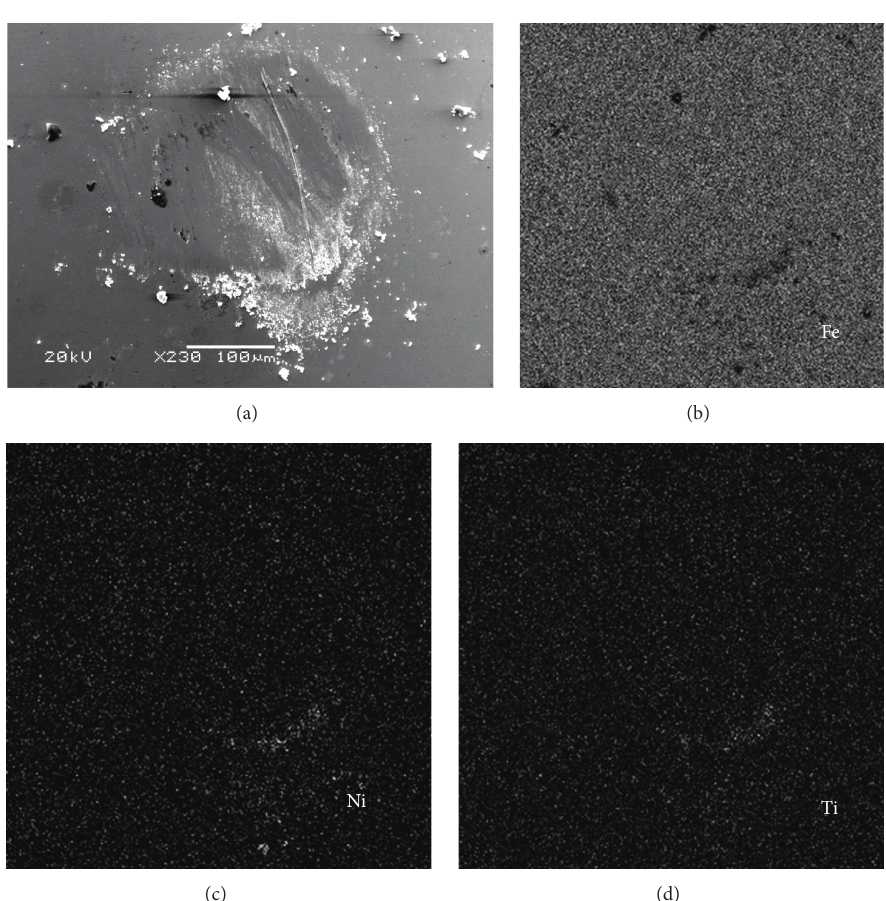
Figure 5: SEM morphologies of (a) wear scar of the steel ball sliding against Ni-Ti coating after the heat treatment at 0.5 N and 3 Hz, (b) Fe element, (c) Ni element, and (d) Ti element distribution thereon.